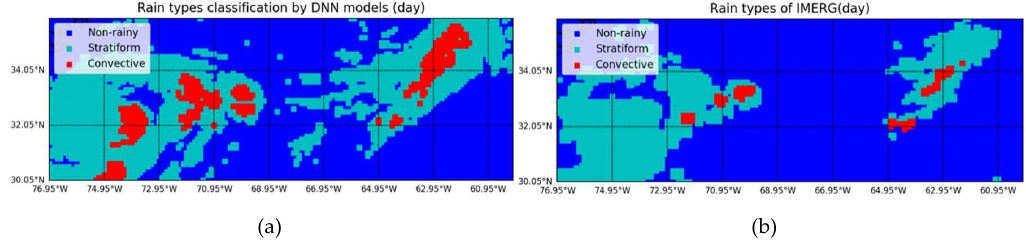
Figure 4. Cloud classification results and IMERG estimations on normal precipitation: ( a ) ABI prediction; and ( b ) IMERG estimation on 9 July 2018, at 13:30–14:00 UTC.